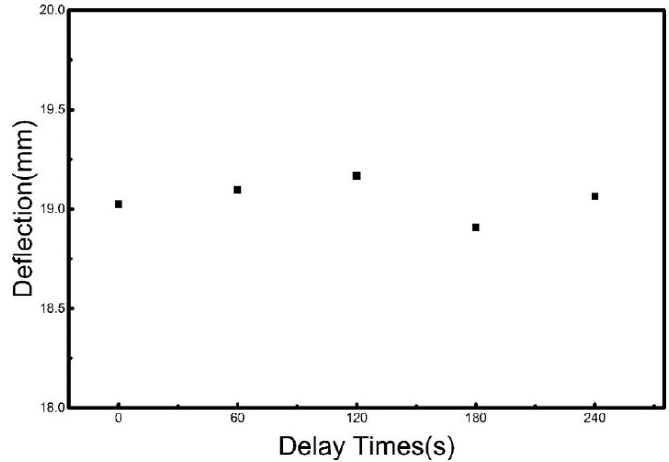
Figure 20. Maximum bending deflection of the S B 1 -S B 1 section for various intervals.